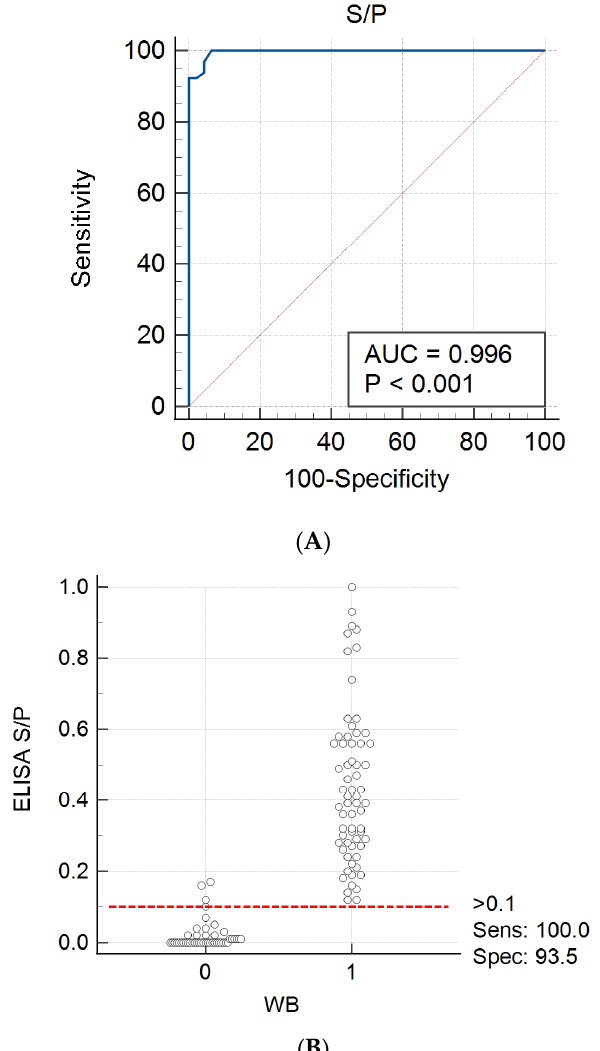
Figure 4. ROC curve ( A ) and the distribution of serological reactivity of horse samples to EFVeca Gag in ELISA and immunoblotting (WB) ( B ). Each grey circle represents S/P value of an individual serum.; numbers on X-axis refer to serum samples negative (0) and positive (1) in immunoblotting; red dashed line indicates the ELISA cut-off value for positive sera (S/P > 0.1). Commas were used as decimal points due to software settings.